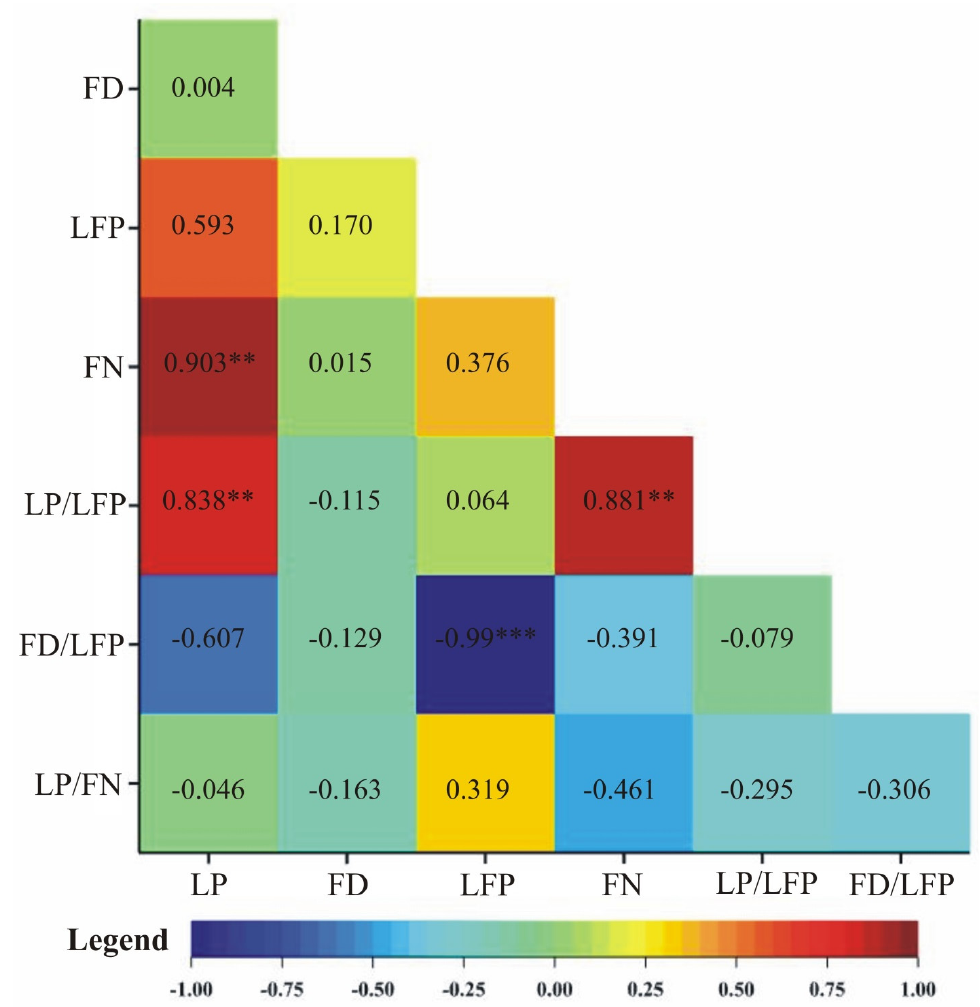
Figure 4. Heatmap for linear Pearson’s correlation coefficients between observed features of P. serotina estimated based on herbicide means (** p < 0.01; *** p < 0.001). LP—length of peduncle, FD—flower diameter, LFP—length of flower peduncle, FN—flower number.